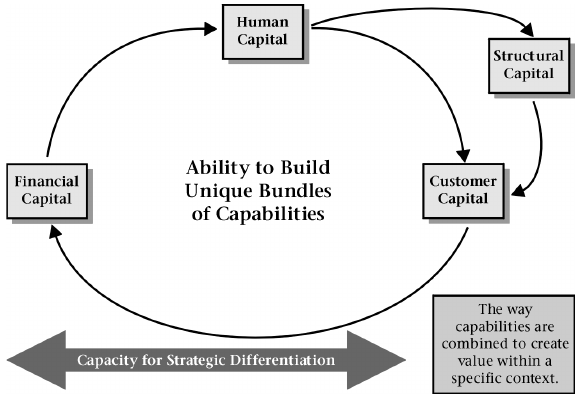
Figure 4: Systemic View of core elements of Intellectual